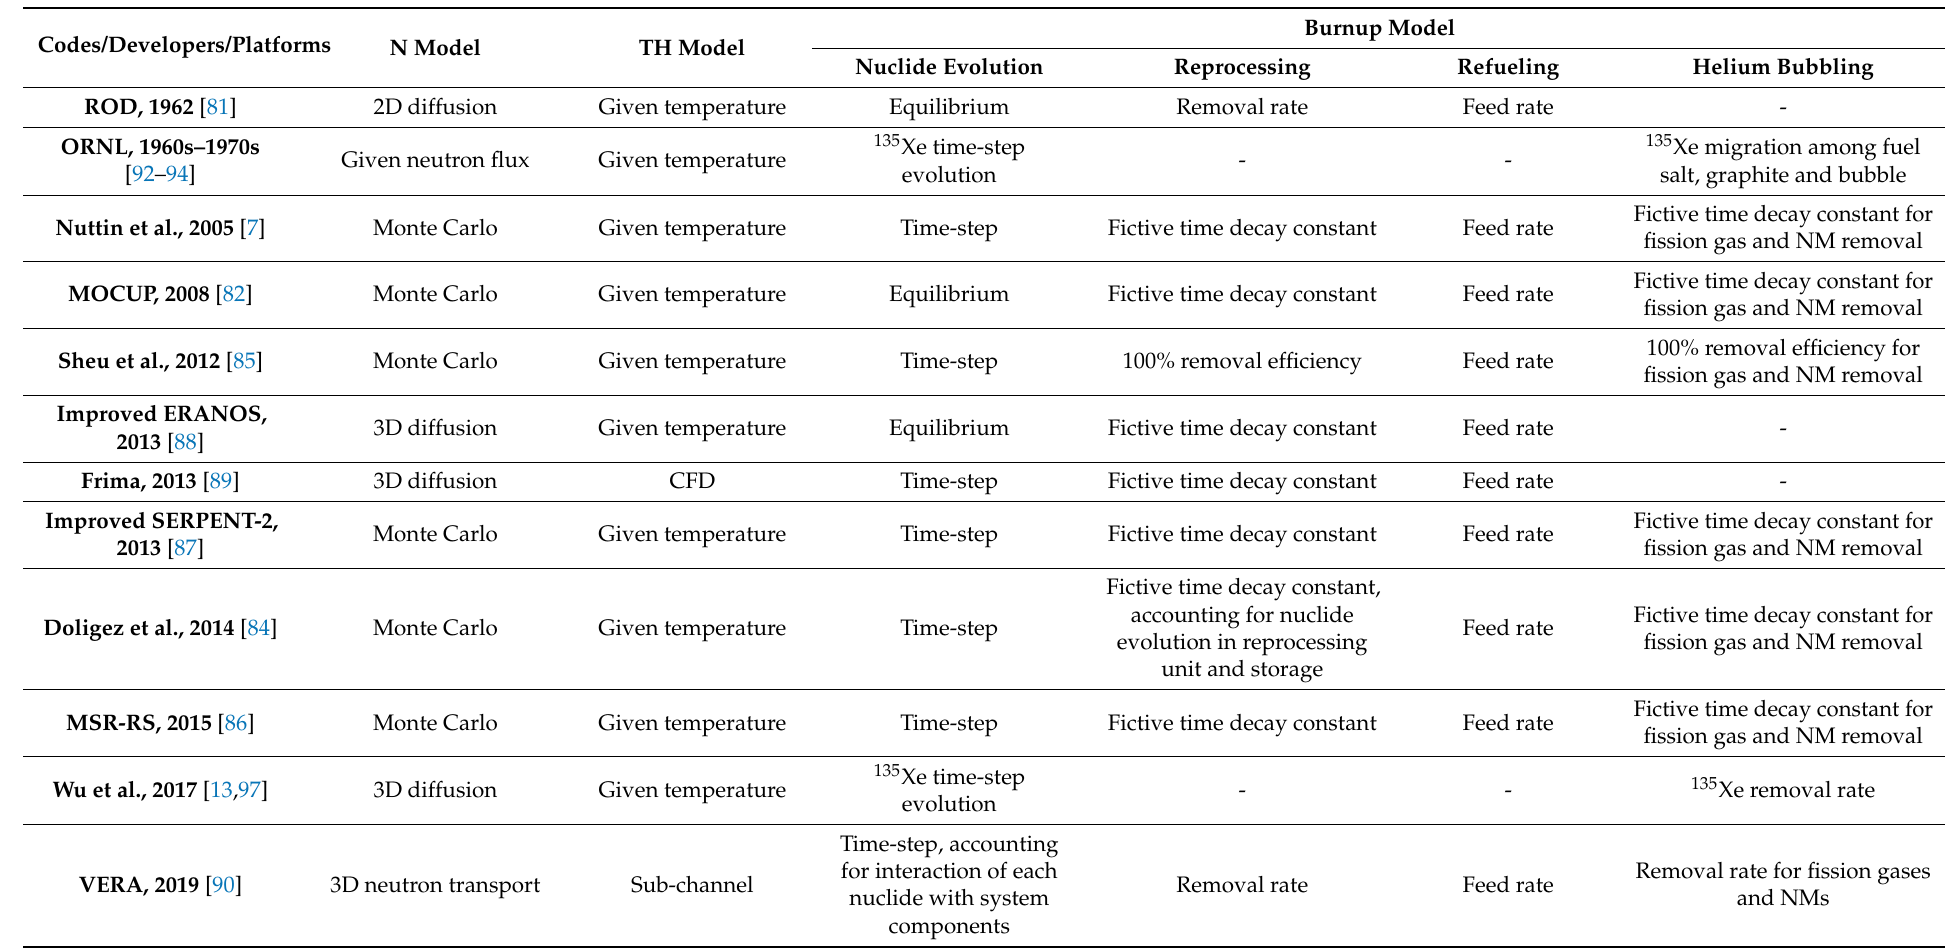
Table 2. Development status of the N-TH-BN coupling